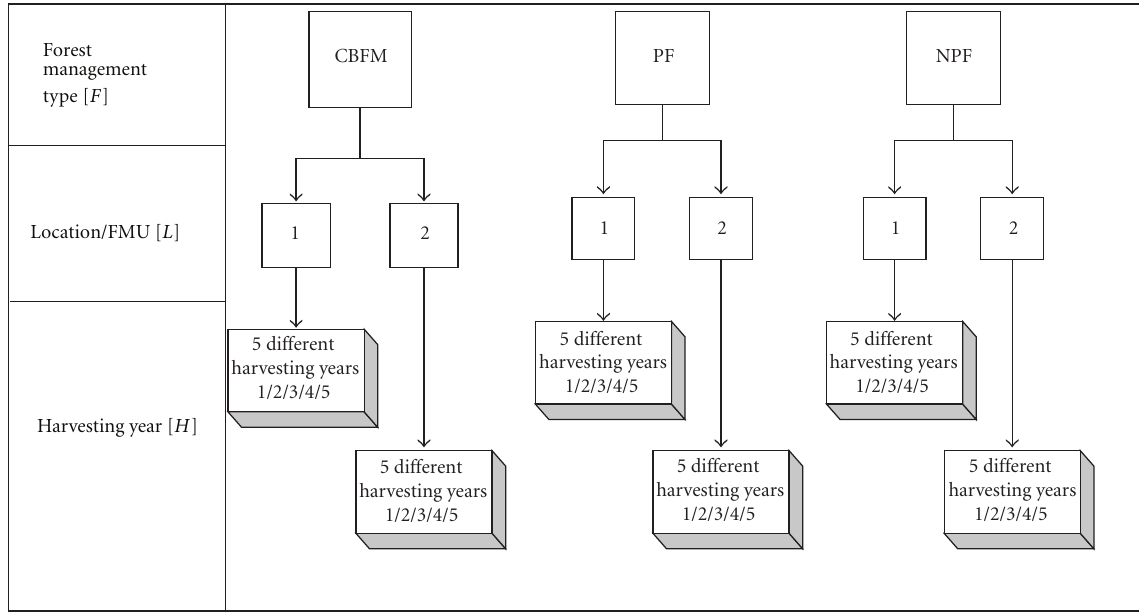
Figure 1: Research design for the forest biomass data collected from the certified forest management units nested in di ff erent forest management types and based on five separate years of data collection. Note: CBFM: Community-Based Forest Management; NPF: Natural Production Forest, and; PF: Plantation